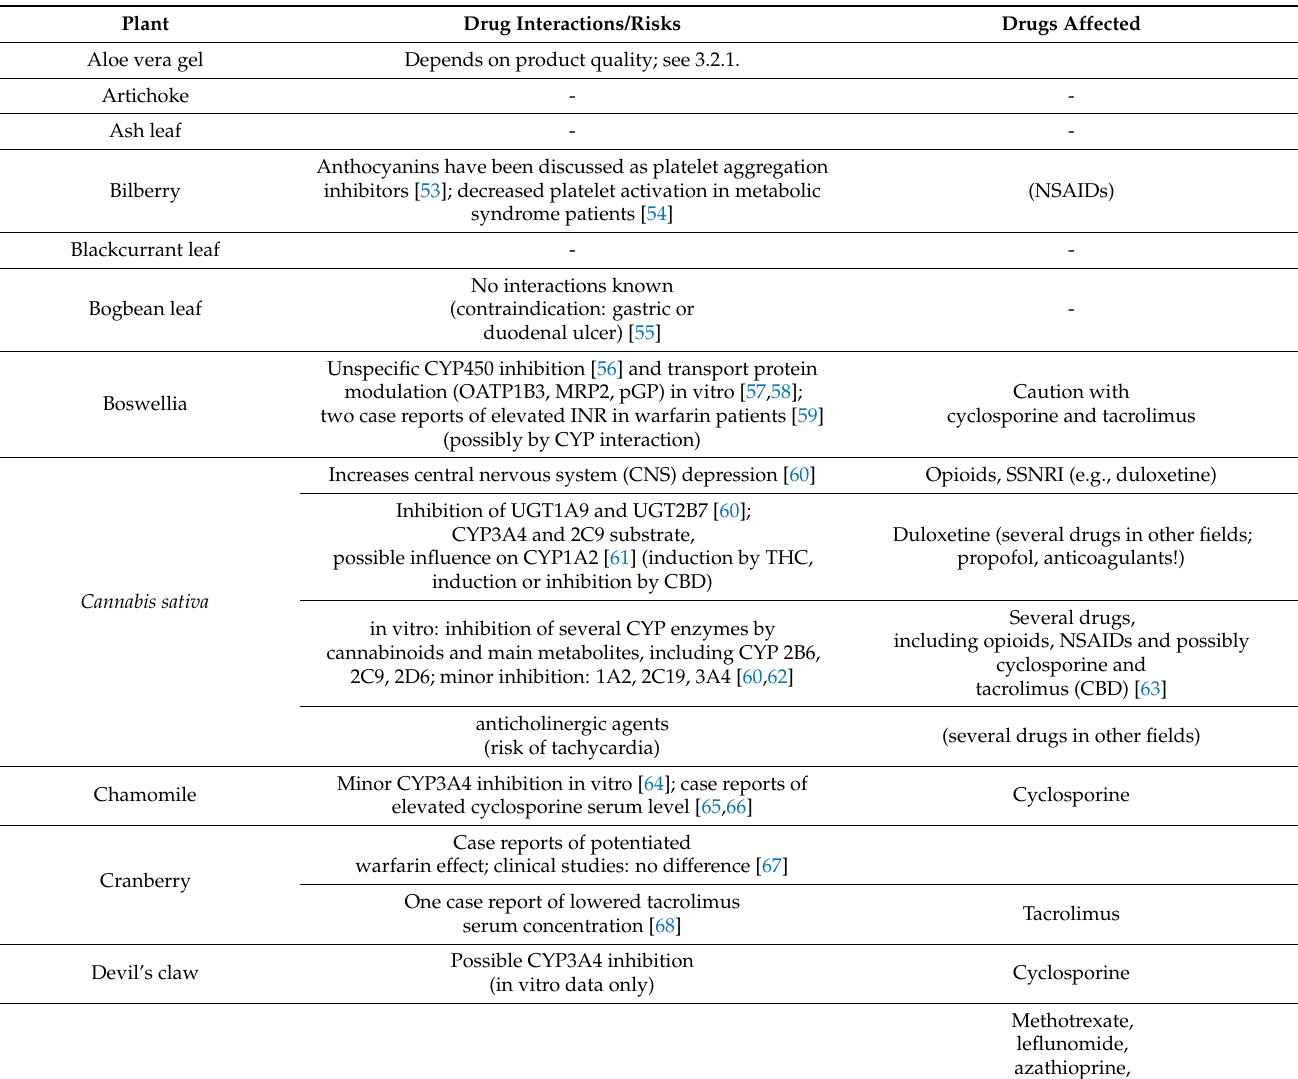
Table 3. This table shows the plants/herbal combination products included in this review, in alphabetic order, and possible herb–drug interaction mechanisms and risks that could cumulate. The right column lists drugs applied in RA/osteoarthritis/IBD treatment that are, or could, be